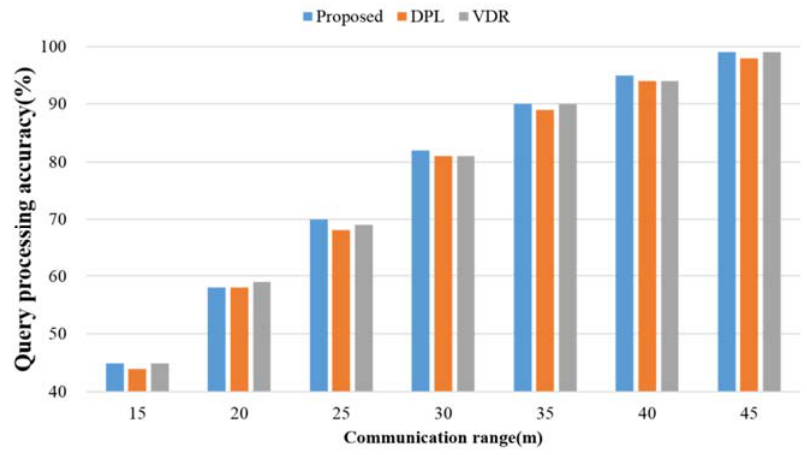
Figure 13. Query-processing accuracy according to communication Figure 13. Query ‐ processing accuracy according to communication range.